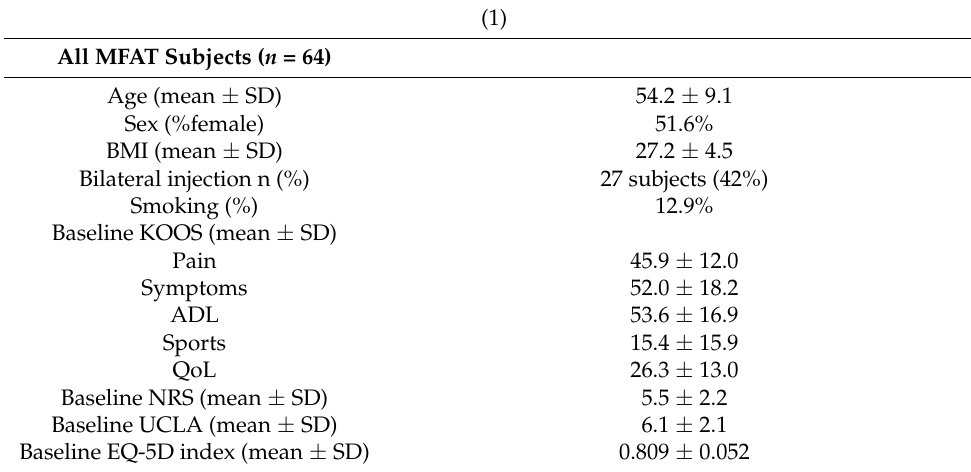
Figure 2. Flowchart of patient enrollment according to the standards of reporting trials statement with numbers of excluded and analyzed subjects. (MFAT, micro-fragmented adipose tissue; FU, follow-up). Table 3. (1) Basic subject characteristics with clinical assessment at baseline of the index knee. (2) Subject demographics of the bilateral injected cohort.